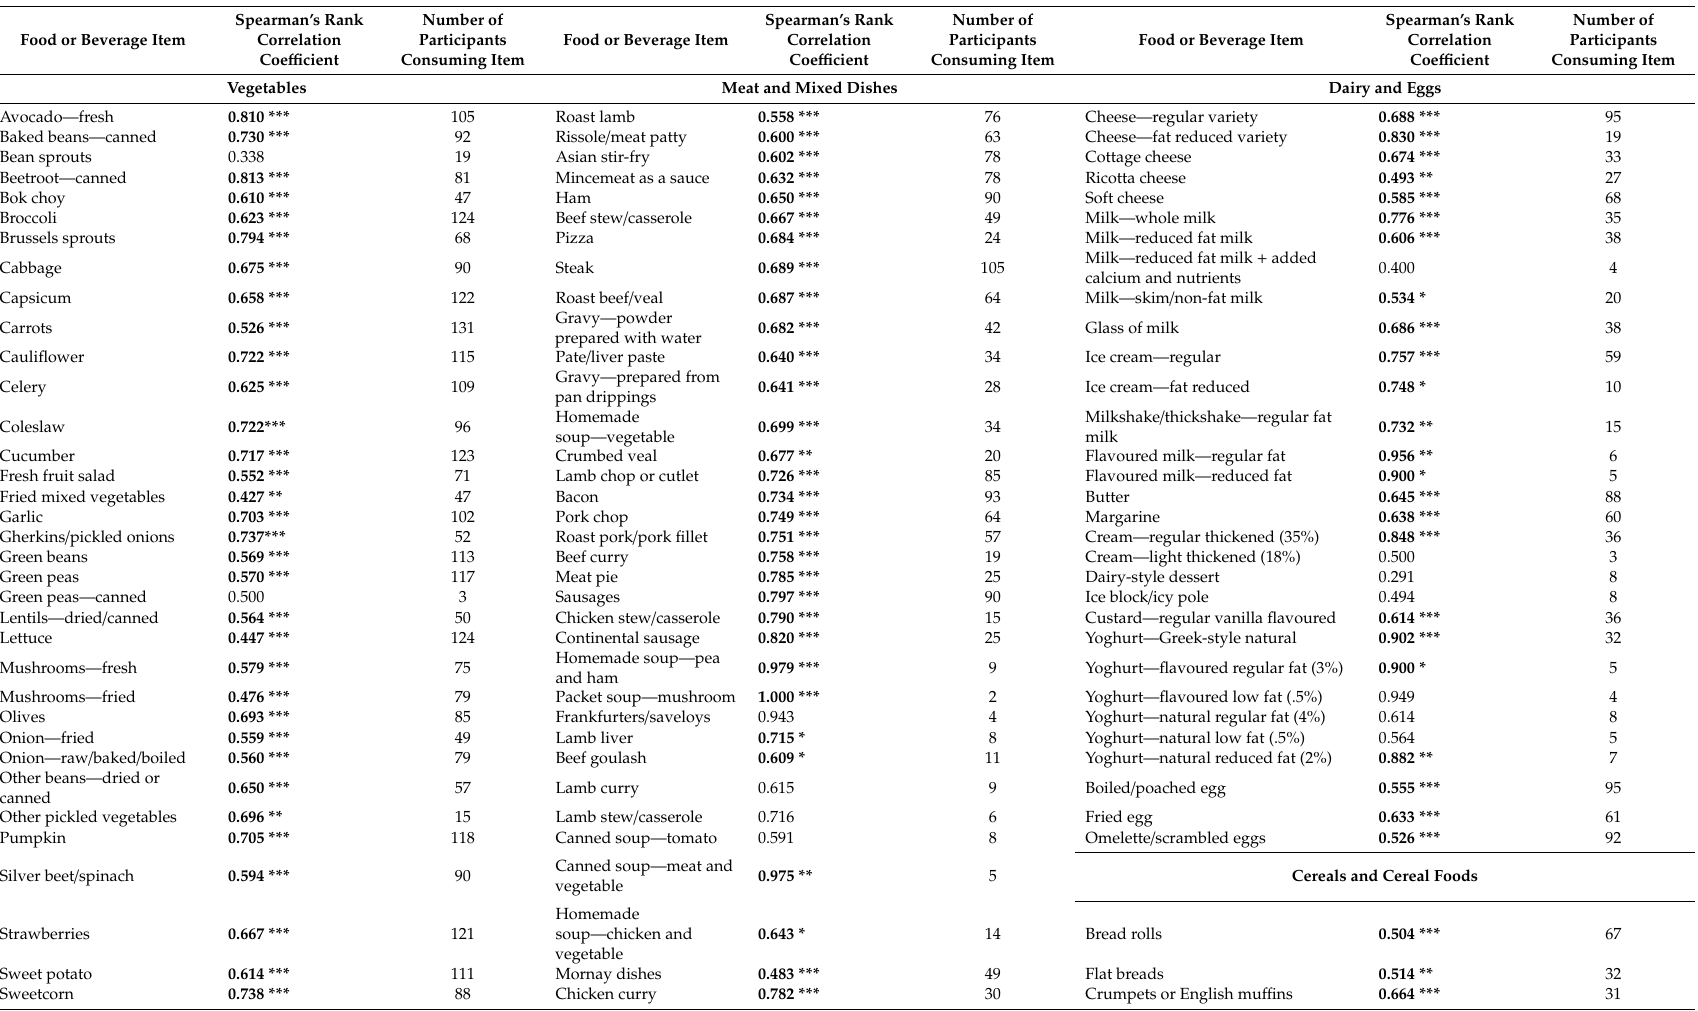
Table 1. Associations between reported food and beverage item intake from two administrations of the Alzheimer’s disease-CSIRO Food Frequency Questionnaire. Food or Beverage Item